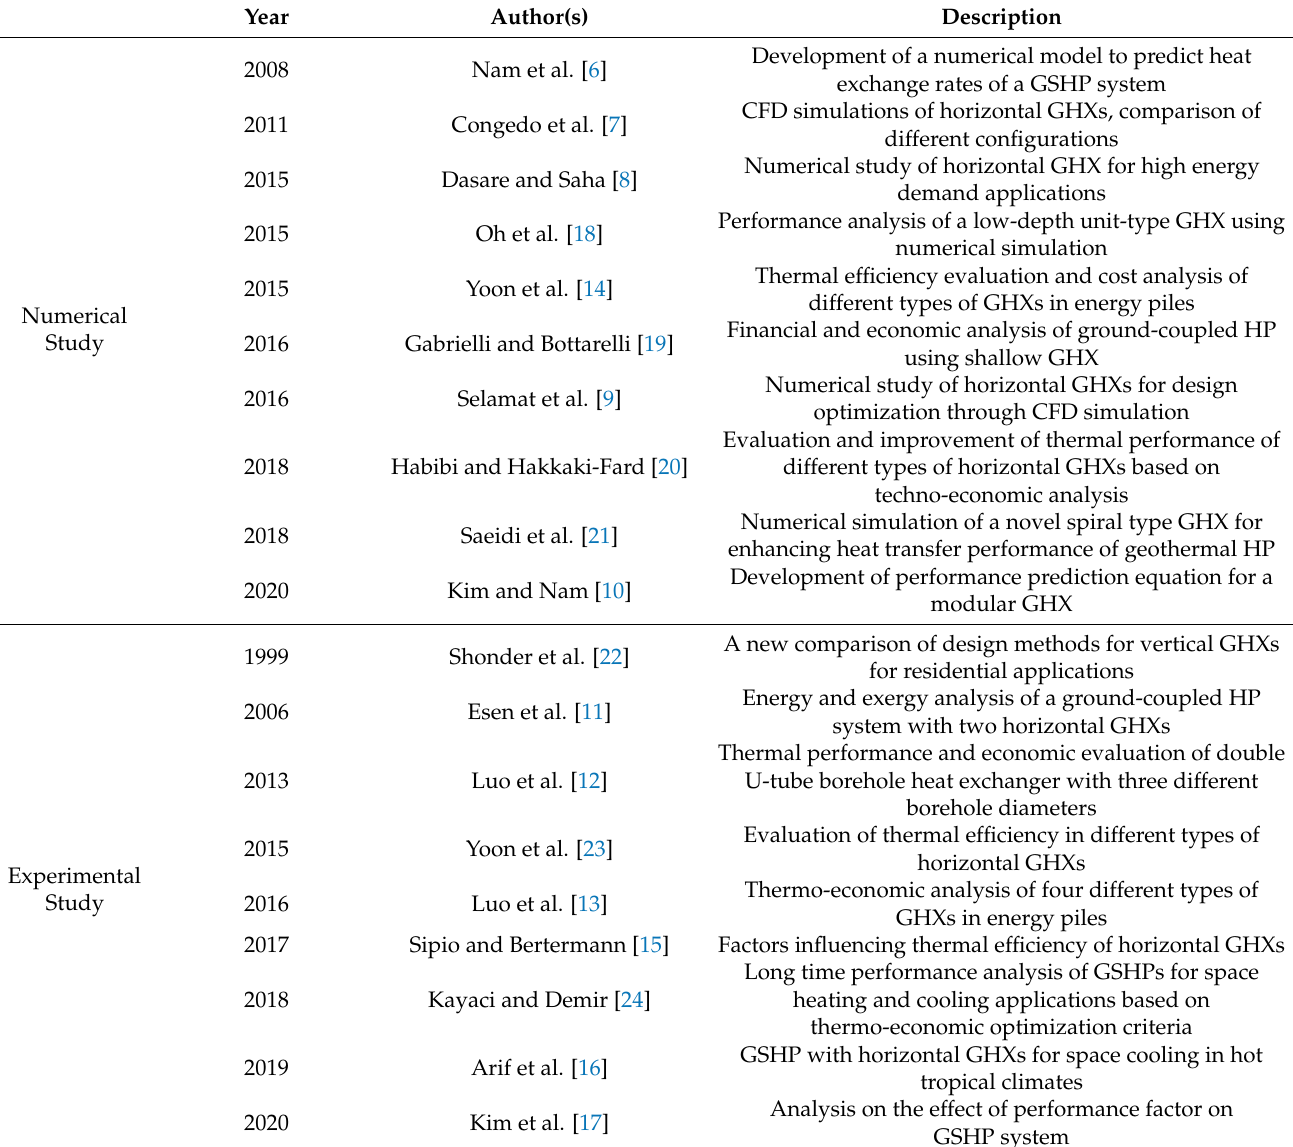
Table 1. Review of numerical and experimental studies on